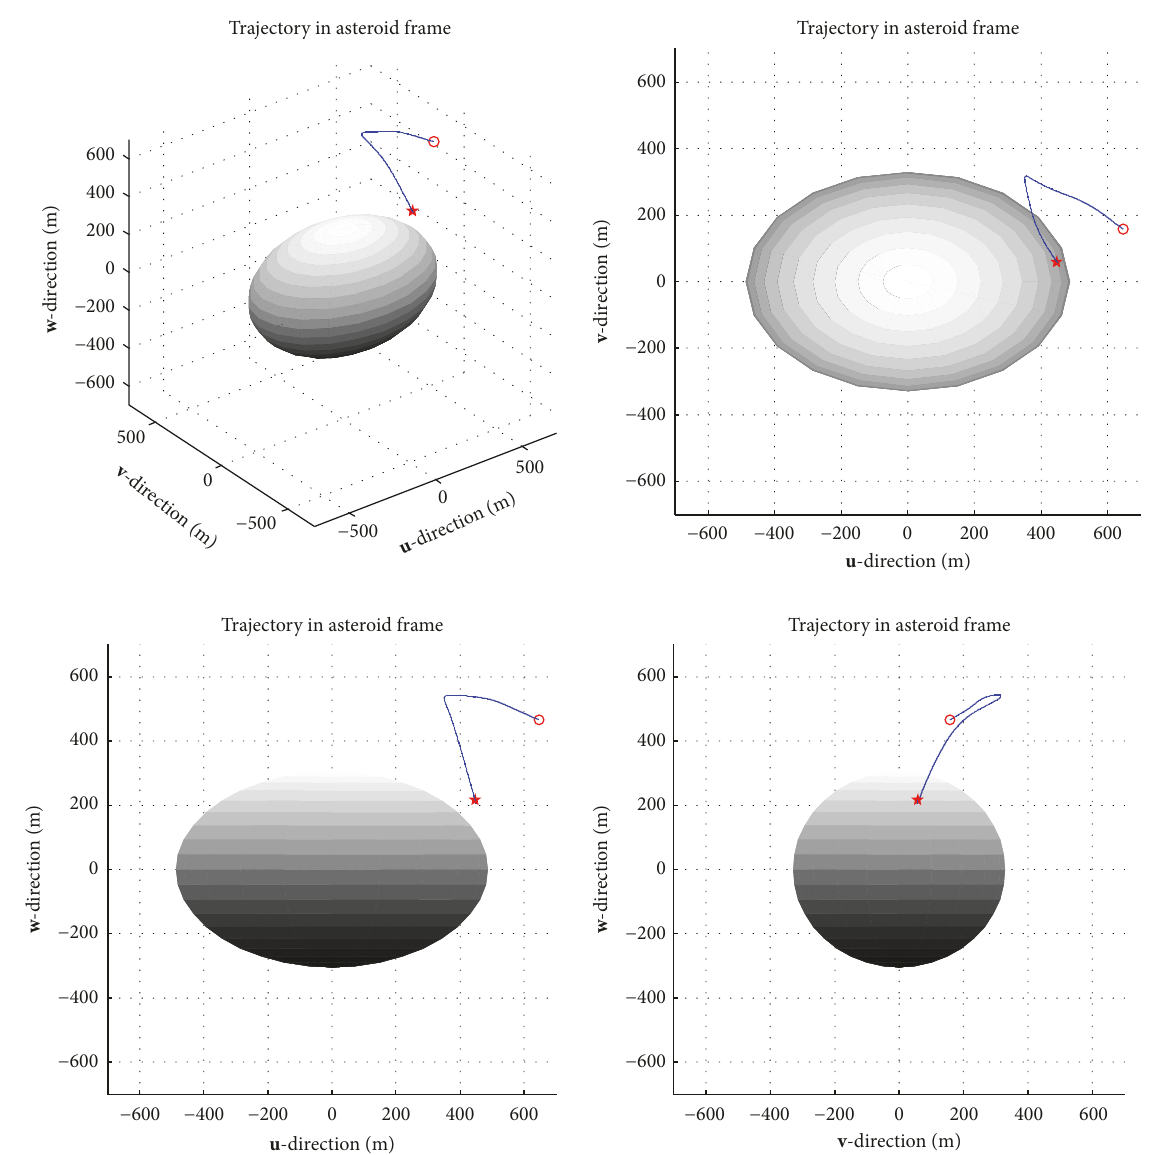
Figure 6: Trajectory of the spacecraft in the asteroid body-fixed frame.